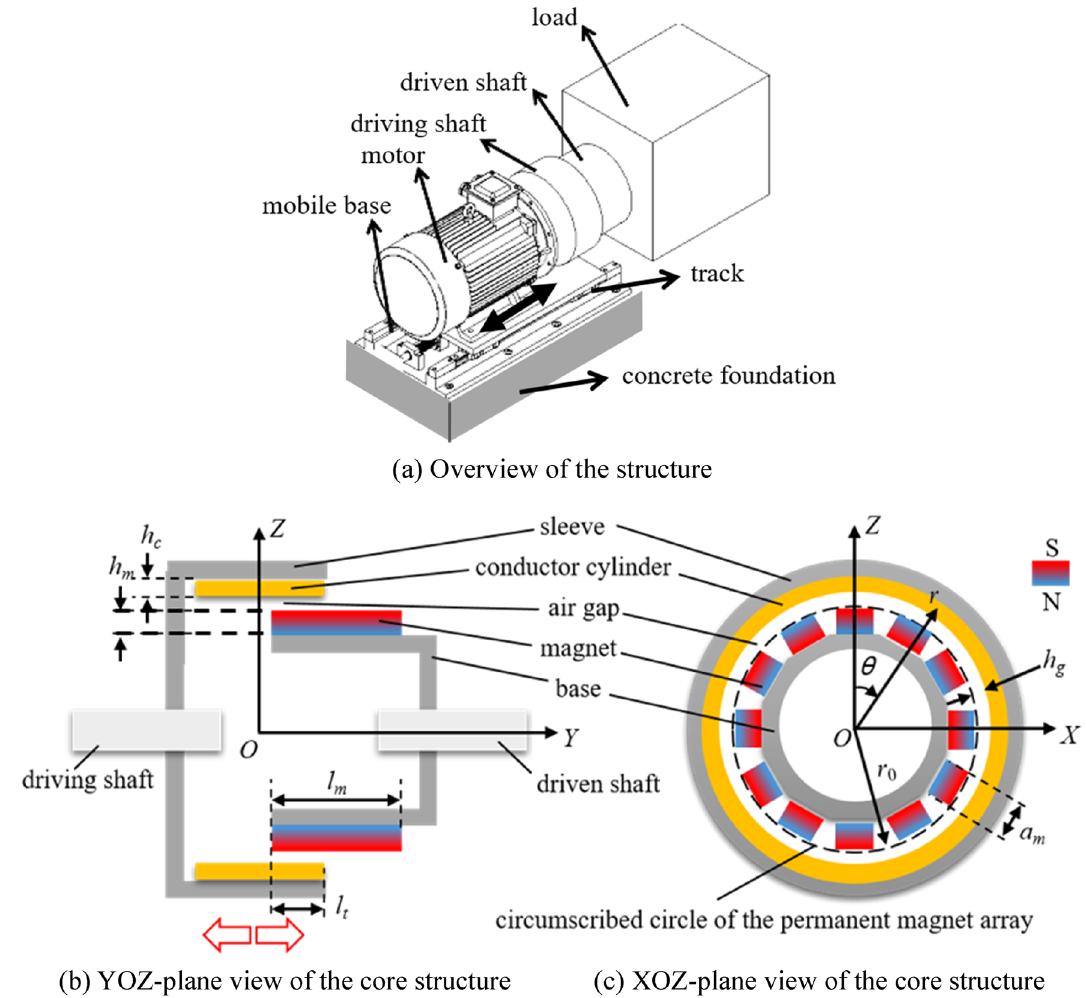
Figure 1. Structure of the permanent magnet speed